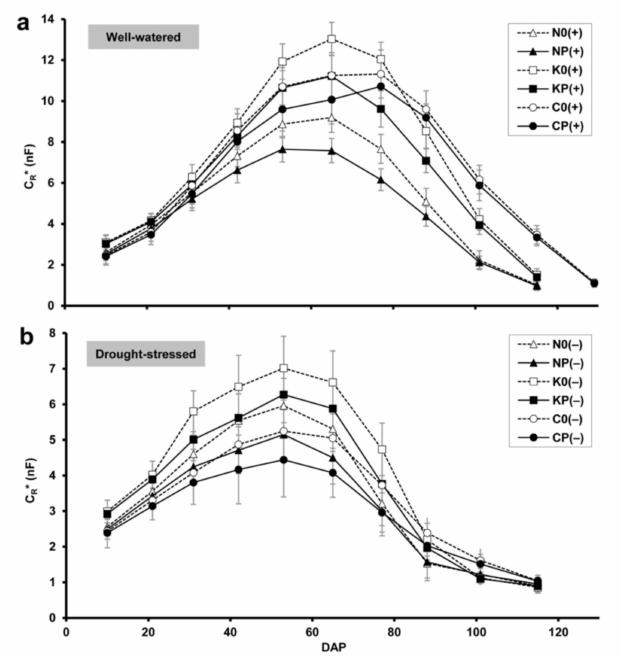
Figure 1. Changes in the apparent root electrical capacitance (C R *; in nanofarads, nF) of wheat with plant age (DAP: days after planting) under ( a ) well-watered and ( b ) drought-stressed conditions. Bars show standard deviations ( n = 30). Treatment codes: N: wheat cv. Mv N á dor; K: cv. Mv Kolompos; C: YQCCP population; 0: wheat sole crop; P: wheat–pea intercrop; (+): well-watered; (–):